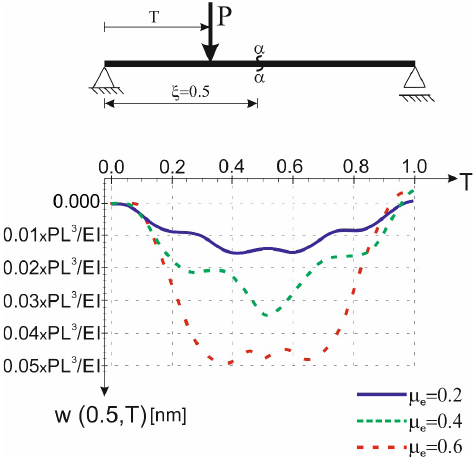
Figure 10: Stress gradient model. Vibrations of the beam in the middle cross-section if 0.05 g η = .